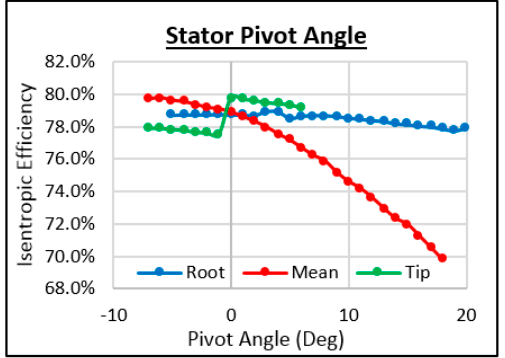
Figure 20. Study of the stator pivot angle.